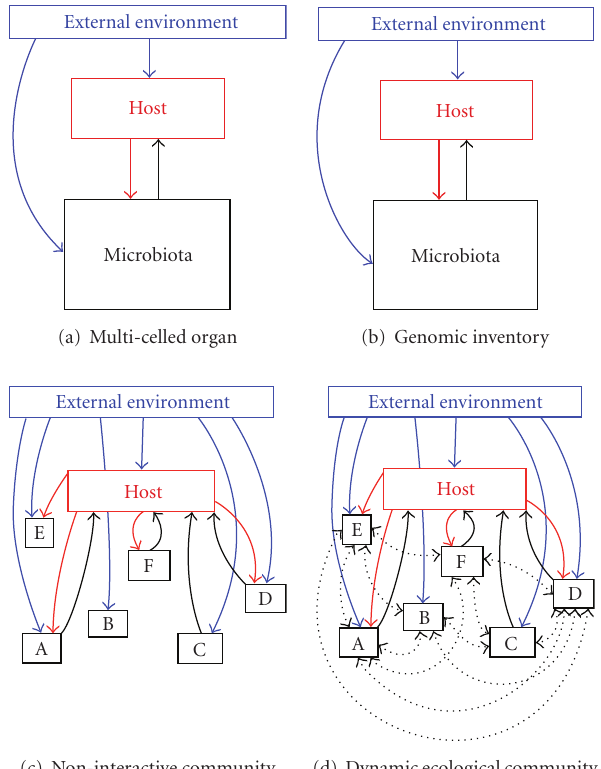
Figure 1: Four conceptualizations of human microbiota that focus to varying degrees on structure and/or function of the microbiota as a whole or of the component microbial taxa. Assumptions and implications of the extremes of simplicity and tractability on one hand (the multicelled organ conceptualization, Figure 1(a)) and complexity and relative intractability (the dynamic ecological com- munity conceptualization, Figure 1(d)) are described in Table 1. All the interactions (linking arrows) are mediated to some extent by changes in the internal environment, which is not shown to enhance clarity. Mechanisms underlying the various interactions, including the role of internal environment, are depicted in Figure